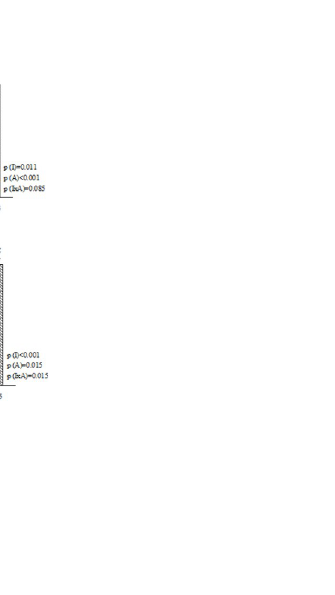
Fig 2. Energy metabolism enzymes in sham and infarcted rats with and without ac¸ai supplementation. (A) β - OHADH: β -hydroxyacyl coenzyme-A dehydrogenase, (B) PDH: pyruvate dehydrogenase complex, (C) CS: citrate synthase, (D) Complex I, (E) LDH: lactate dehydrogenase. Data are expressed as mean ± SEM. Same letter represents a significant difference between groups (p < 0.005). Sample size: SA0 = 8; SA2 = 8; SA5 = 8; IA0 = 8; IA2 = 8; IA5 = 8.